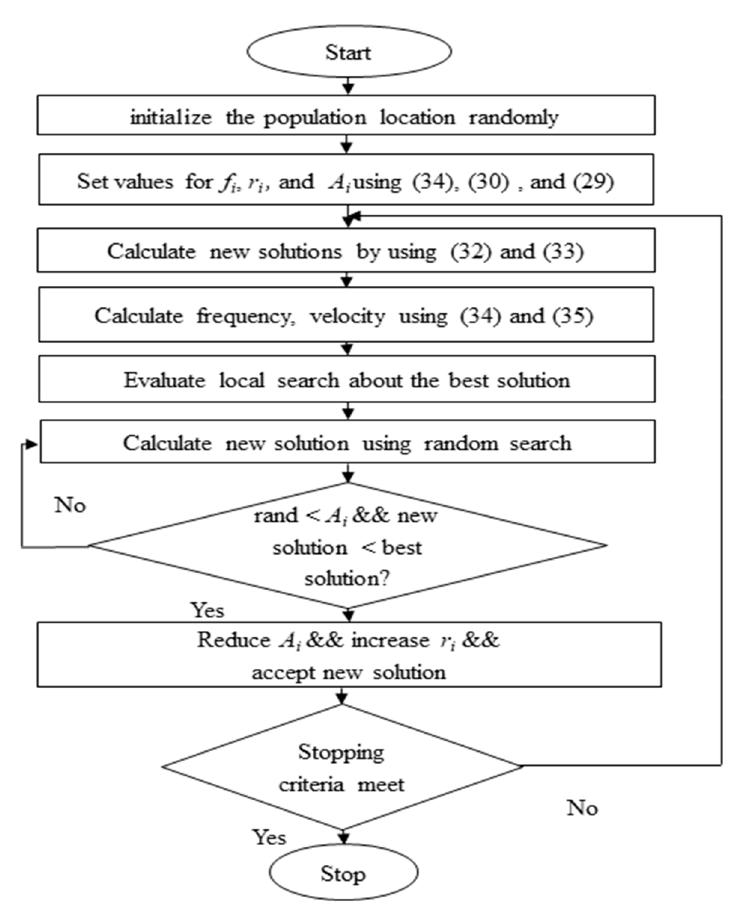
Figure 3. Flowchart of quantum-behaved bat algorithm (QBA).